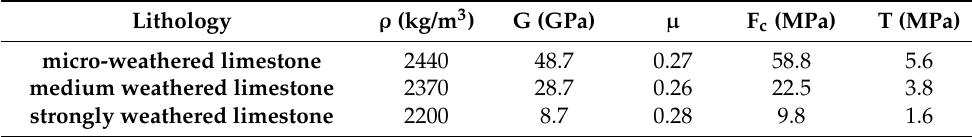
Table 6. Limestone